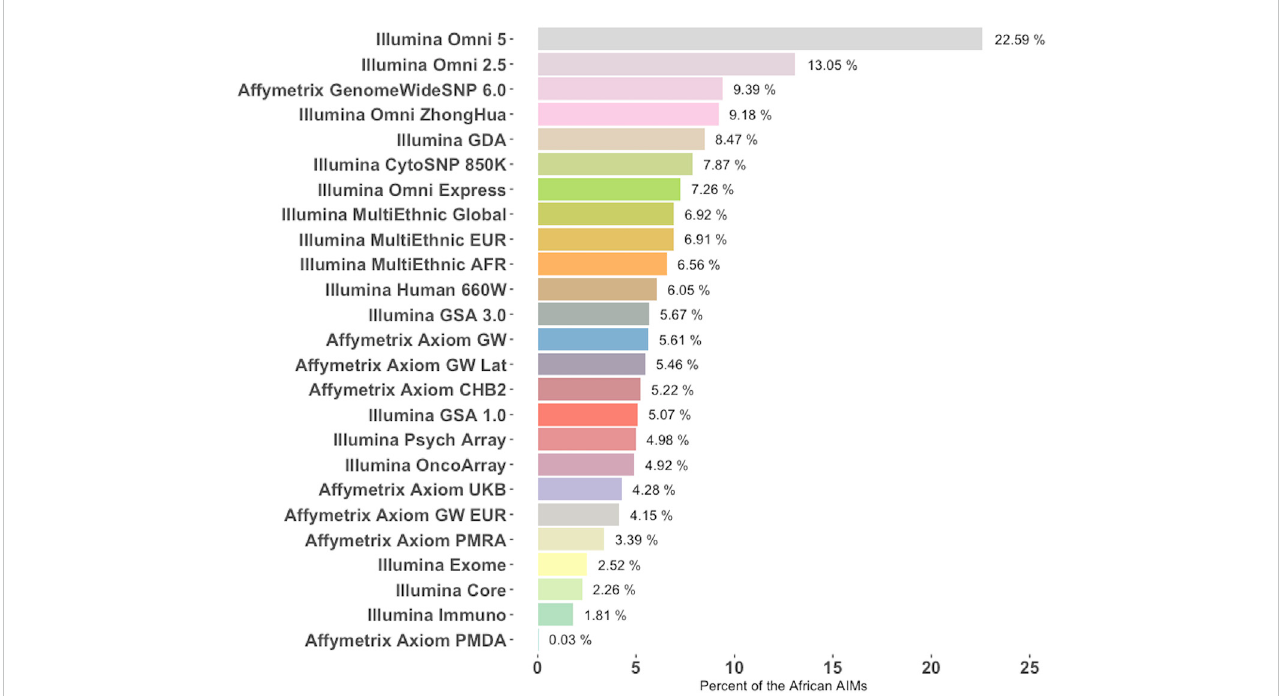
FIGURE 6 Percentage of African AIMs from this study that are represented in commercial genotyping arrays. Twenty- fi ve commonly used genotyping platforms werechosenfromIlluminaandAffymetrix( y -Axis)andthefractionofSNPsdifferentiatingtheAfricanpopulationfromothers(i.e.,AIMsfromthisstudy)islisted for each array. Platforms are ranked from most representative of the AIMs panel from this study to the